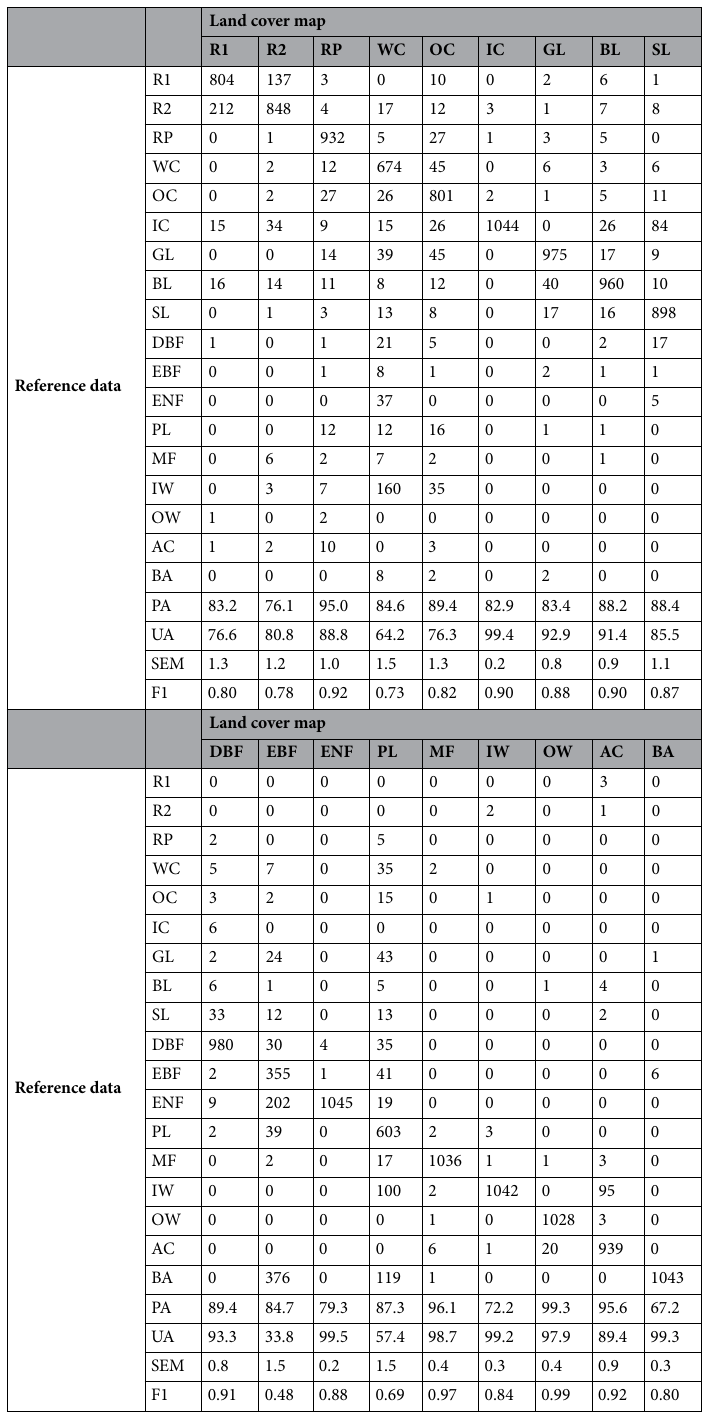
Table 2. Confusion matrix of the 2020 Vietnam-wide LULC map (Level 2) created from the integration of Landsat OLI, and Sentinel SAR GRD and MSI satellite images with the random-forest-based algorithm. PA: Producer accuracy (%); UA: User accuracy (%); SEM: Standard error of the mean for UA; F1: F1 score; Overall accuracy: 84.7%, and Kappa coefficient: 83.8 (%). R1: Residence 1; R2: Residence 2; RP: Rice paddies; WC: Woody crops; OC: Other crops; IC: In-house crops; GL: Grassland; BL: Barren land; SL: Scrubland; DBF: Deciduous broadleaf forest; EBR: Evergreen broadleaf forest; ENF: Evergreen needleleaf forest; PL: Plantation land; MF: Mangrove forest; IW: Inland wetland; OW: Open water; AC: Aquaculture; BA: Bamboo